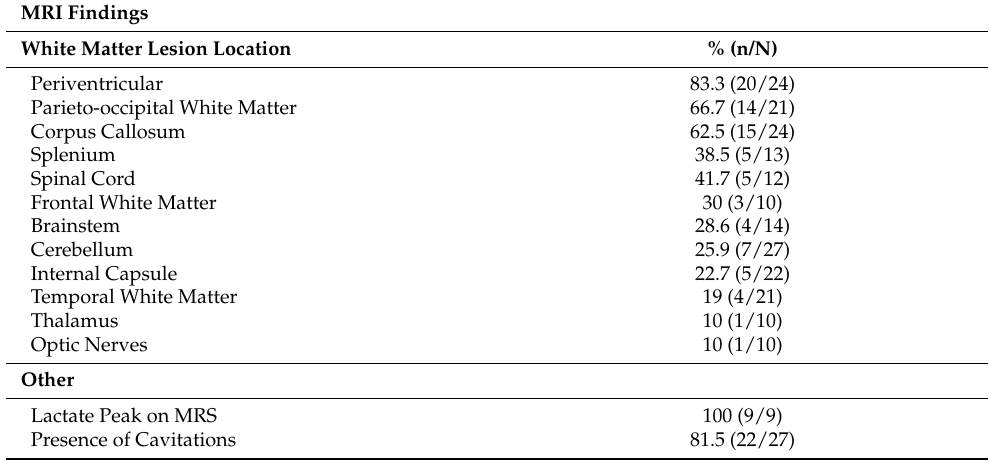
Table 3. Neuroradiographic characteristics of multiple mitochondrial dysfunction syndrome type 3